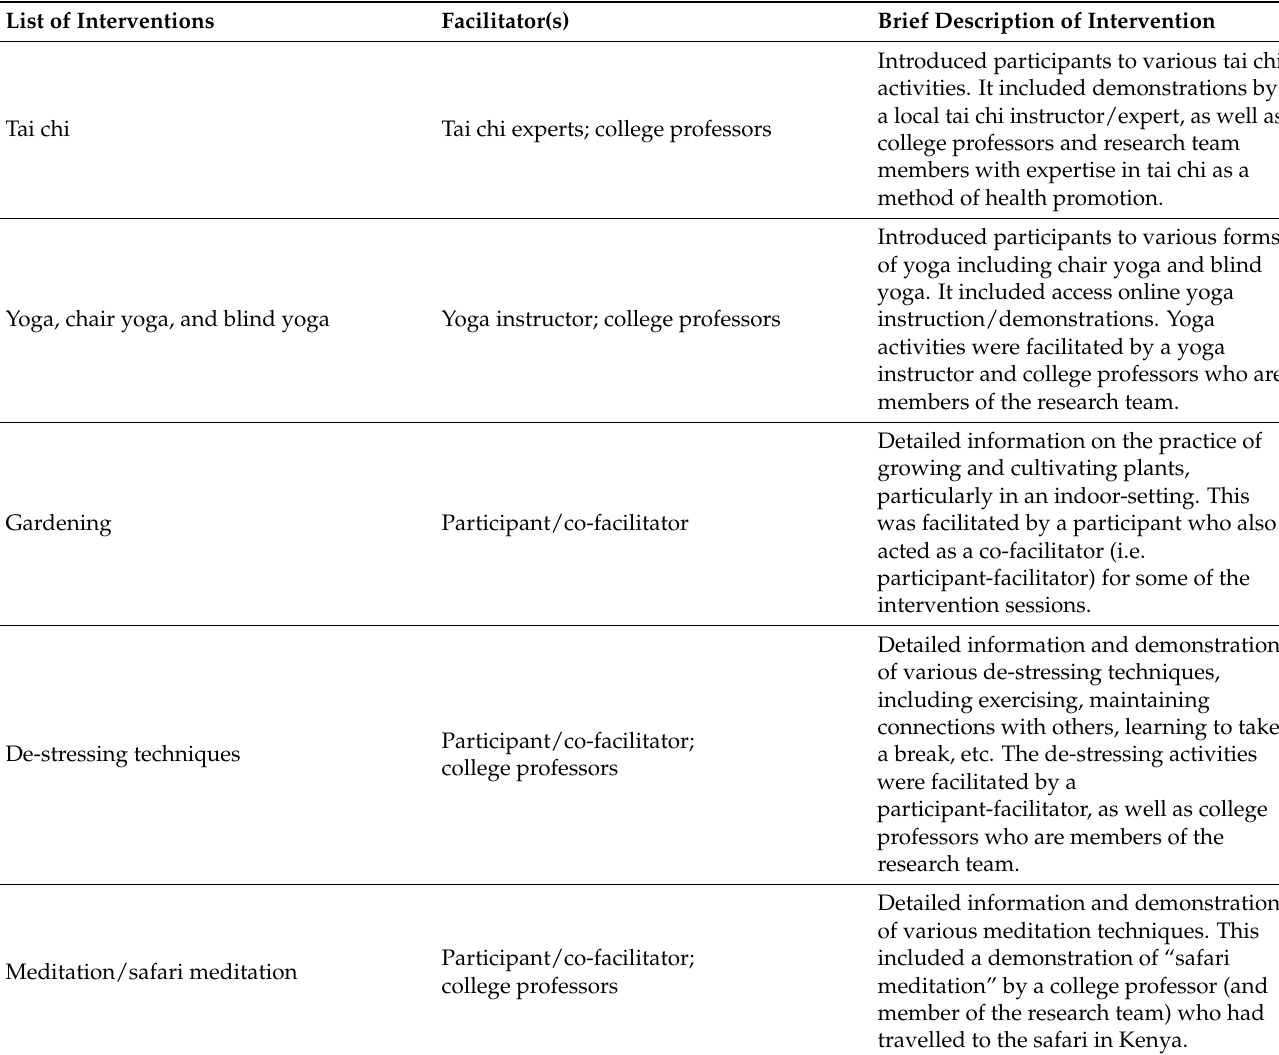
Table 2. List of